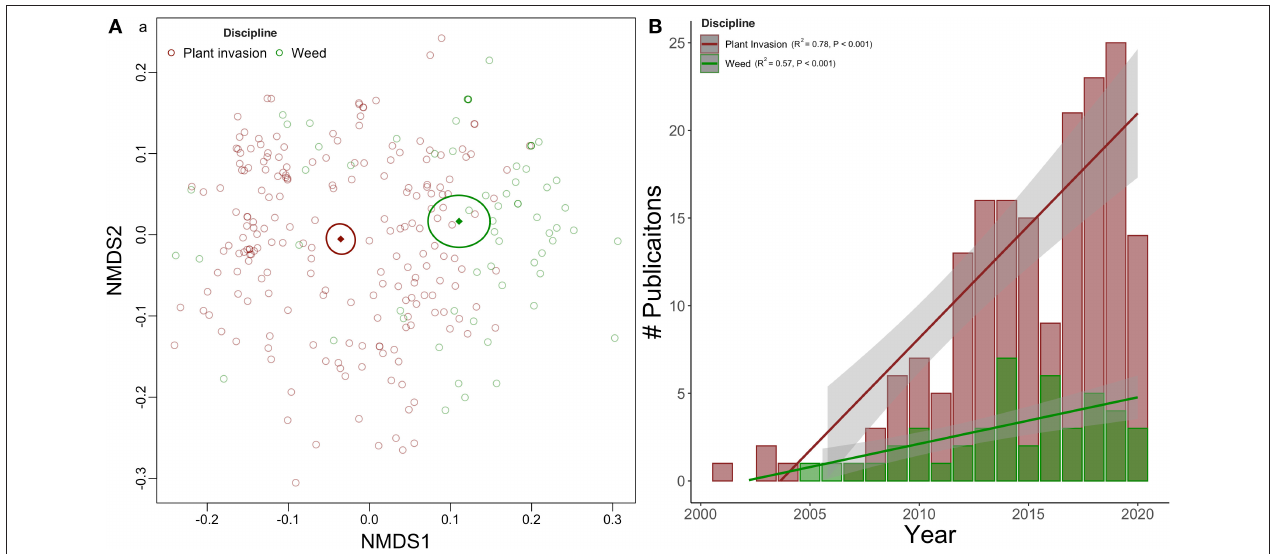
FIGURE 1 | (A) Non-metric multidimensional scaling (NMDS) ordination of the overall compositions of the study categories and sub-categories of the two disciplines based on Bray–Curtis dissimilarities (stress = 0.15). Points represent individual studies, and ellipses represent standard errors (SE) around the mean centroid of each discipline. (B) Number of publications per year that address climate change features for the two disciplines with their linear regression